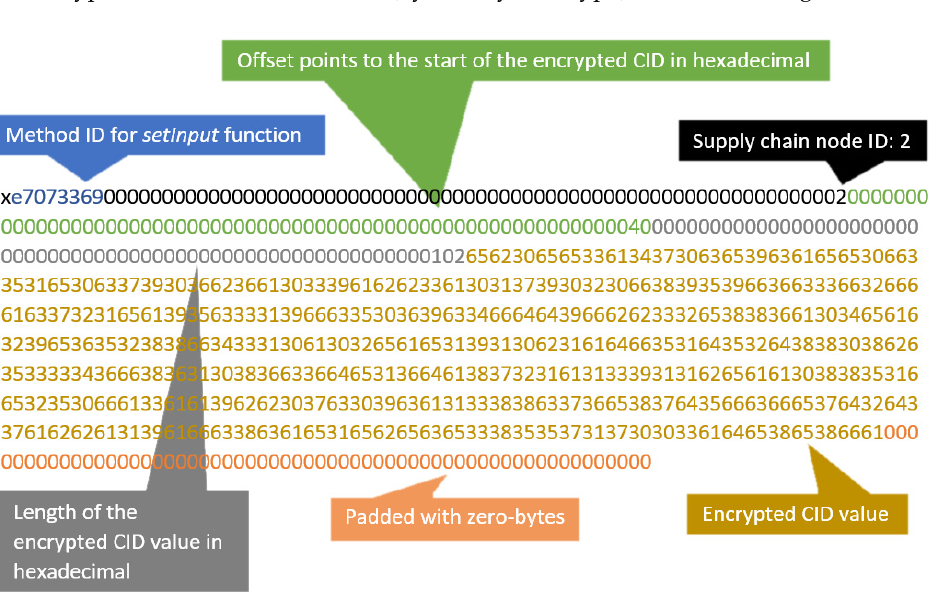
Figure 3. Transaction